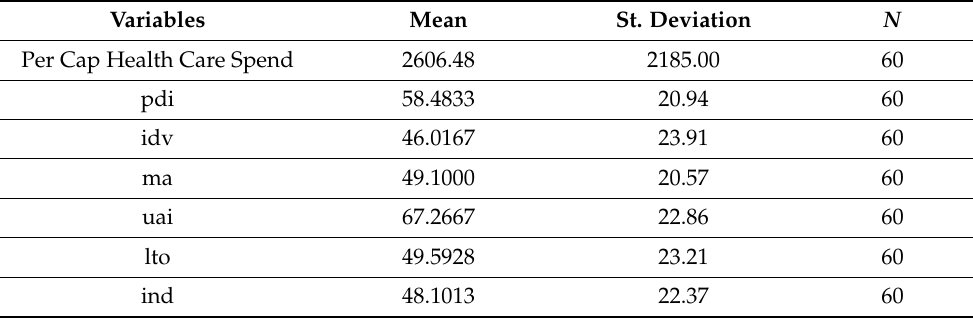
Table 3. Per Capita Health Care Spending Model 2: Descriptive